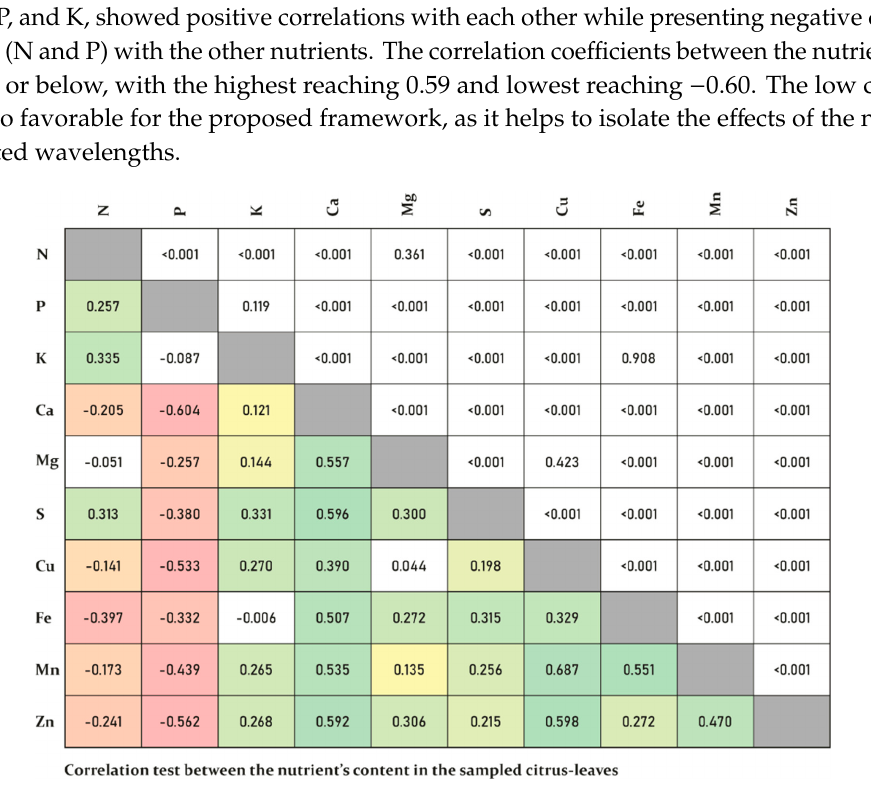
Figure 4. Correlation between the measured nutrients for the Valencia-orange leaf samples.